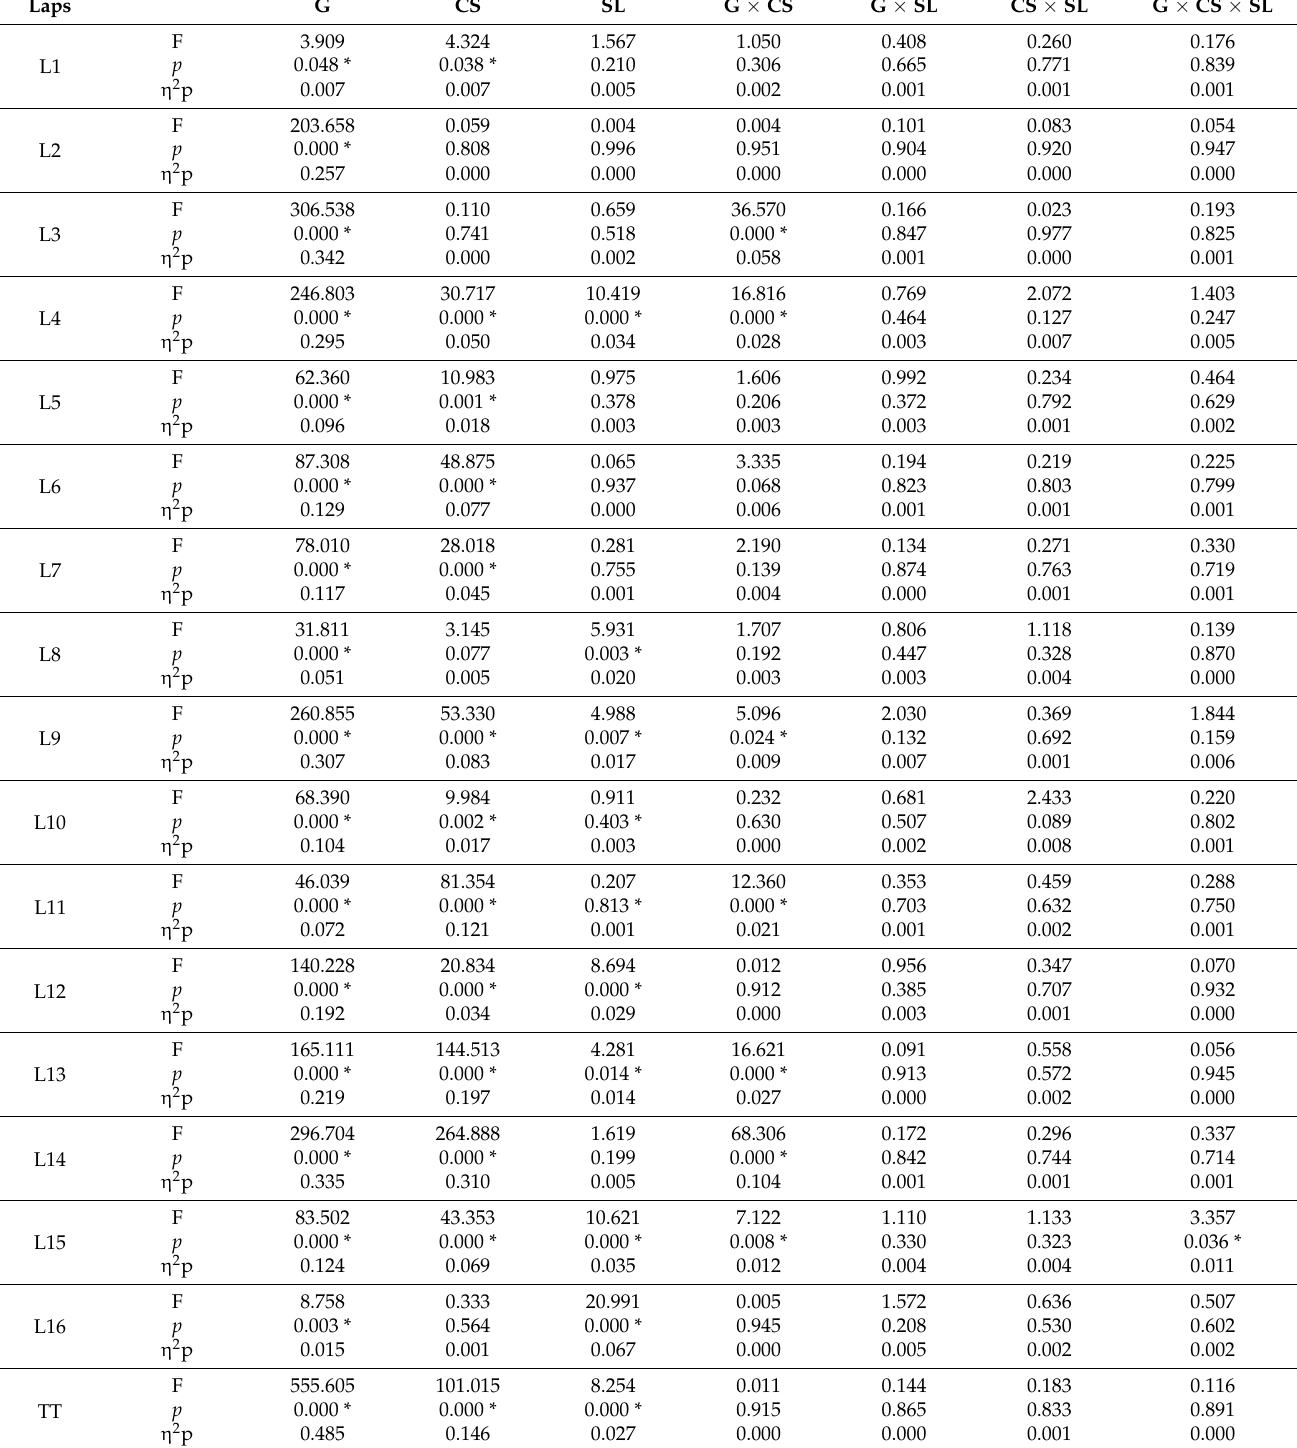
Table 2. Three-ways ANOVA for each lap time and total time